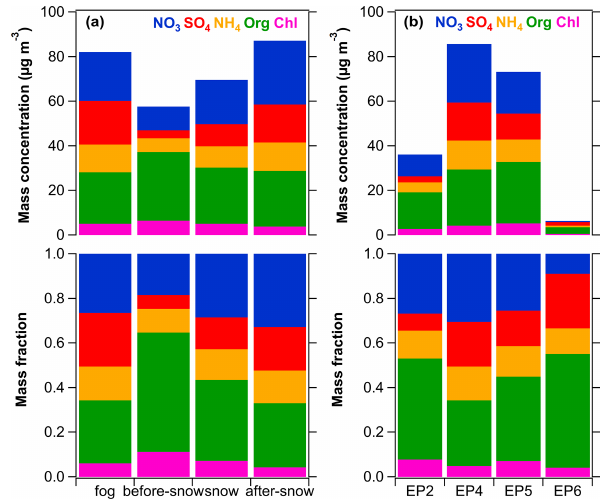
Figure 6. Changes in mass concentration and mass fractions of aerosol species during different